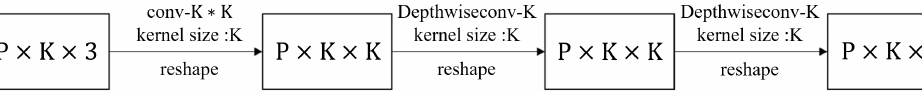
Figure 9. Transformation Ξ -matrix.